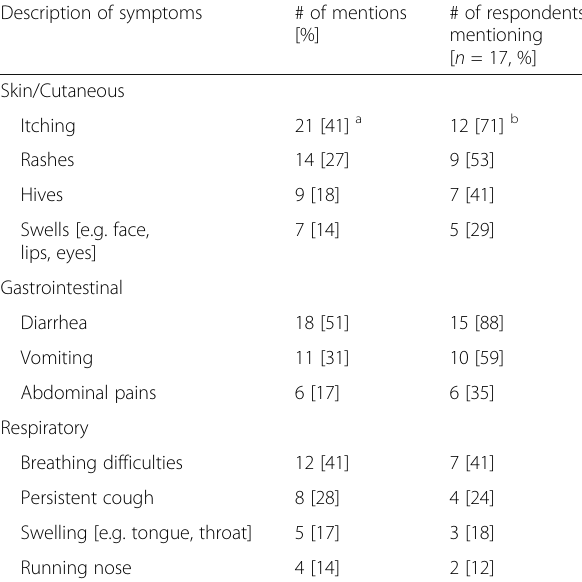
Table 4 Healthcare workers report of clinical signs and symptoms of food